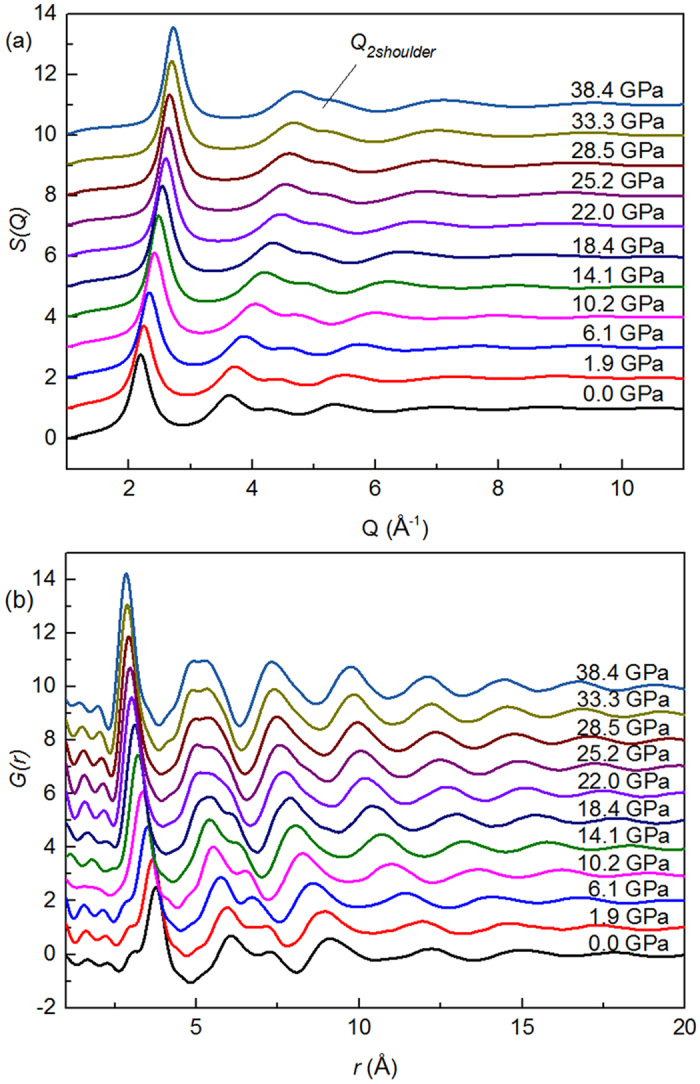
(a) Structure factor S(Q) and (b) pair distribution function G(r) of the Yb62.5Zn15Mg17.5Cu5 metallic glass at various pressure conditions.